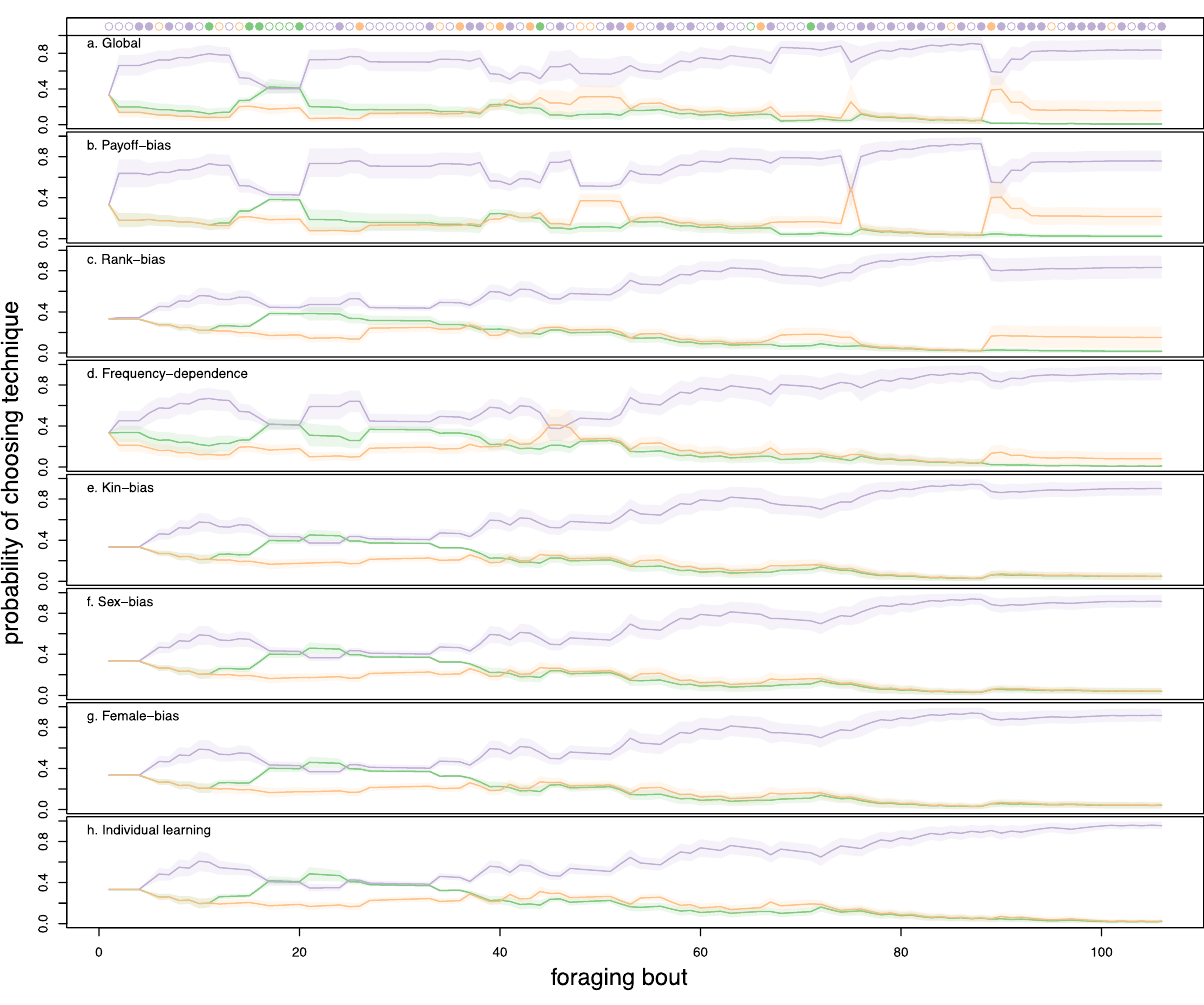
Figure 3. Model predictions of the probability of using a technique across foraging bouts from the seven models for the behavioural time series of individual ‘Gran’ in NH group. Colours correspond to the three processing techniques (purple: ‘CMS’; orange: ‘CMT’; green: ‘CH’). Lines show posterior mean predictions of the probability of choosing a behaviour at each time step. Lines are like three-sided dice whose odds change as a function of observed social and experienced personal information over each foraging bout. The “roll” of each die estimates the processing technique observed by ‘Gran’ at each foraging bout, plotted along the top row. Filled circles are successes, empty circles are failures. The shaded interval is a 89% high posterior density intervals (HPDI). 89% HPDI correspond to the range containing 89% of probable